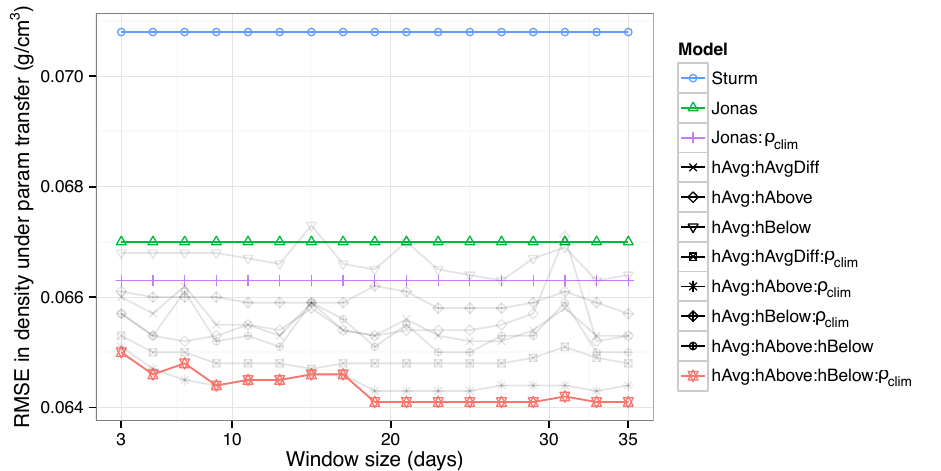
Fig. B1. Comparison of model RMSE in density (over all observations) under parameter transfer as a function of window size for computing the running mean of snow depth predictor h Avg and the associated predictors h AvgDiff (all anomalies), h Above (positive anomalies), and h Below (negative anomalies). ρ clim is the daily density climatology of fitting data